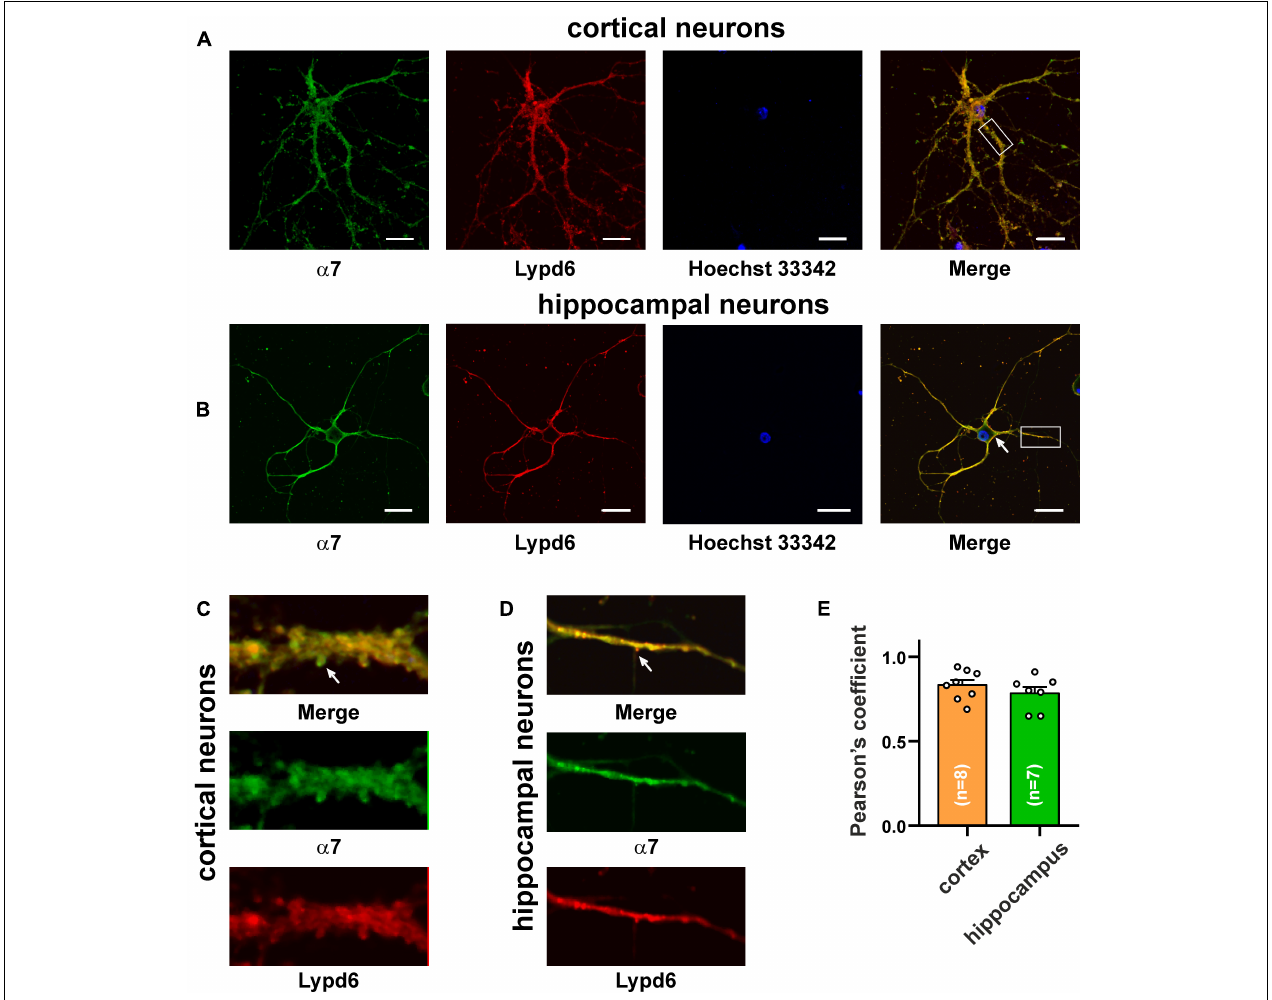
FIGURE 3 | Co-localization of endogenous Lypd6 and nAChRs containing α 7 subunit in primary cortical and hippocampal neurons. Cells were sequentially incubated with the mouse anti- α 7/rabbit anti-Lypd6 antibodies and secondary anti-mouse Alexa-488 (green)/anti-rabbit TRITC (red) labeled antibodies, respectively. (A,C) Colocalization of Lypd6 and the α 7 subunit in the cortical neurons. (B,D) Colocalization of Lypd6 and the α 7 subunit in the hippocampal neurons. Scale bar 10 µ m. (C,D) Enlarged fragments showed by white rectangles on (A,B) , respectively. Points with the different Lypd6 and α 7 expression are shown by arrows. (E) Pearson’s correlation coefficients of the Lypd6 and α 7 colocalization in primary cortical and hippocampal neurons ( n = 4, microphotographs).